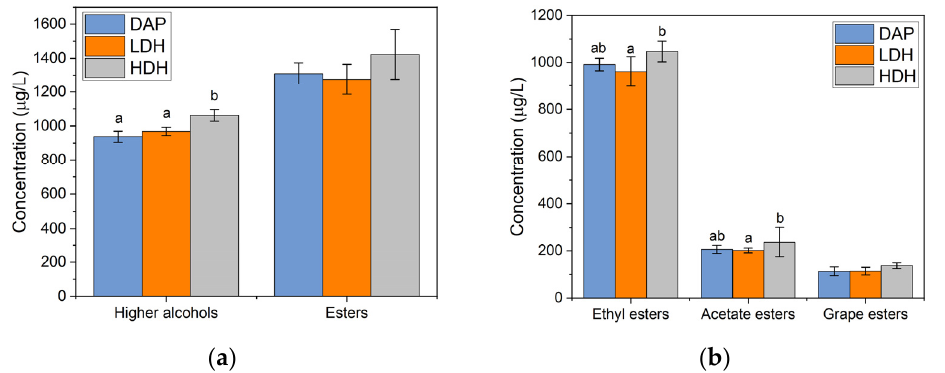
Figure 4. Characterization of Cabernet Sauvignon wines produced by supplemented fermentations with different nitrogen sources: ( a ) total higher alcohols and total esters, ( b ) ethyl, acetate, and grape esters. Different letters indicate significant differences ( p < 0.05).